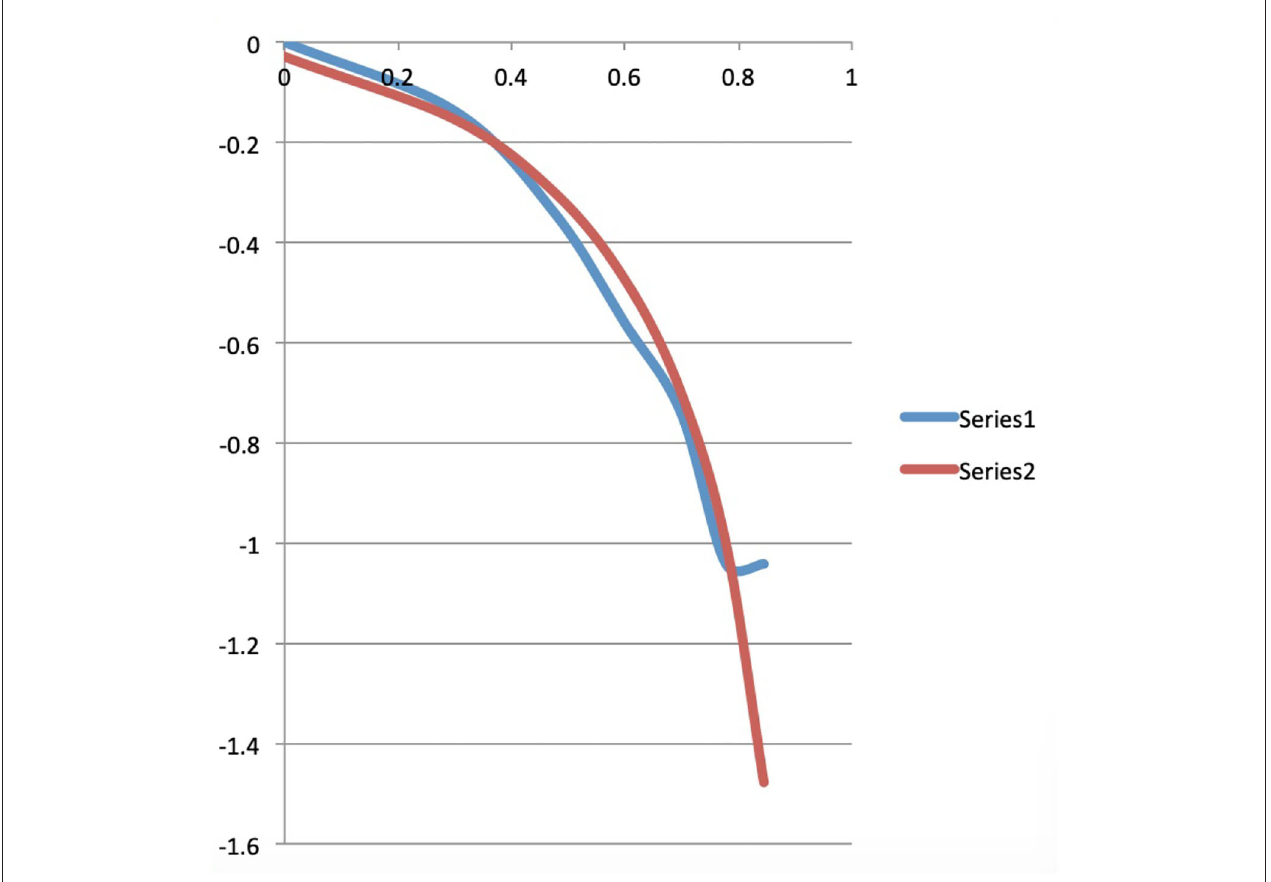
FIGURE 6 | The blue and red curves are the log/log graphs of the Bose-Einstein and Maxwell-Boltzmann functions of the situation of four words distributed over seven energy levels with total energy equal to